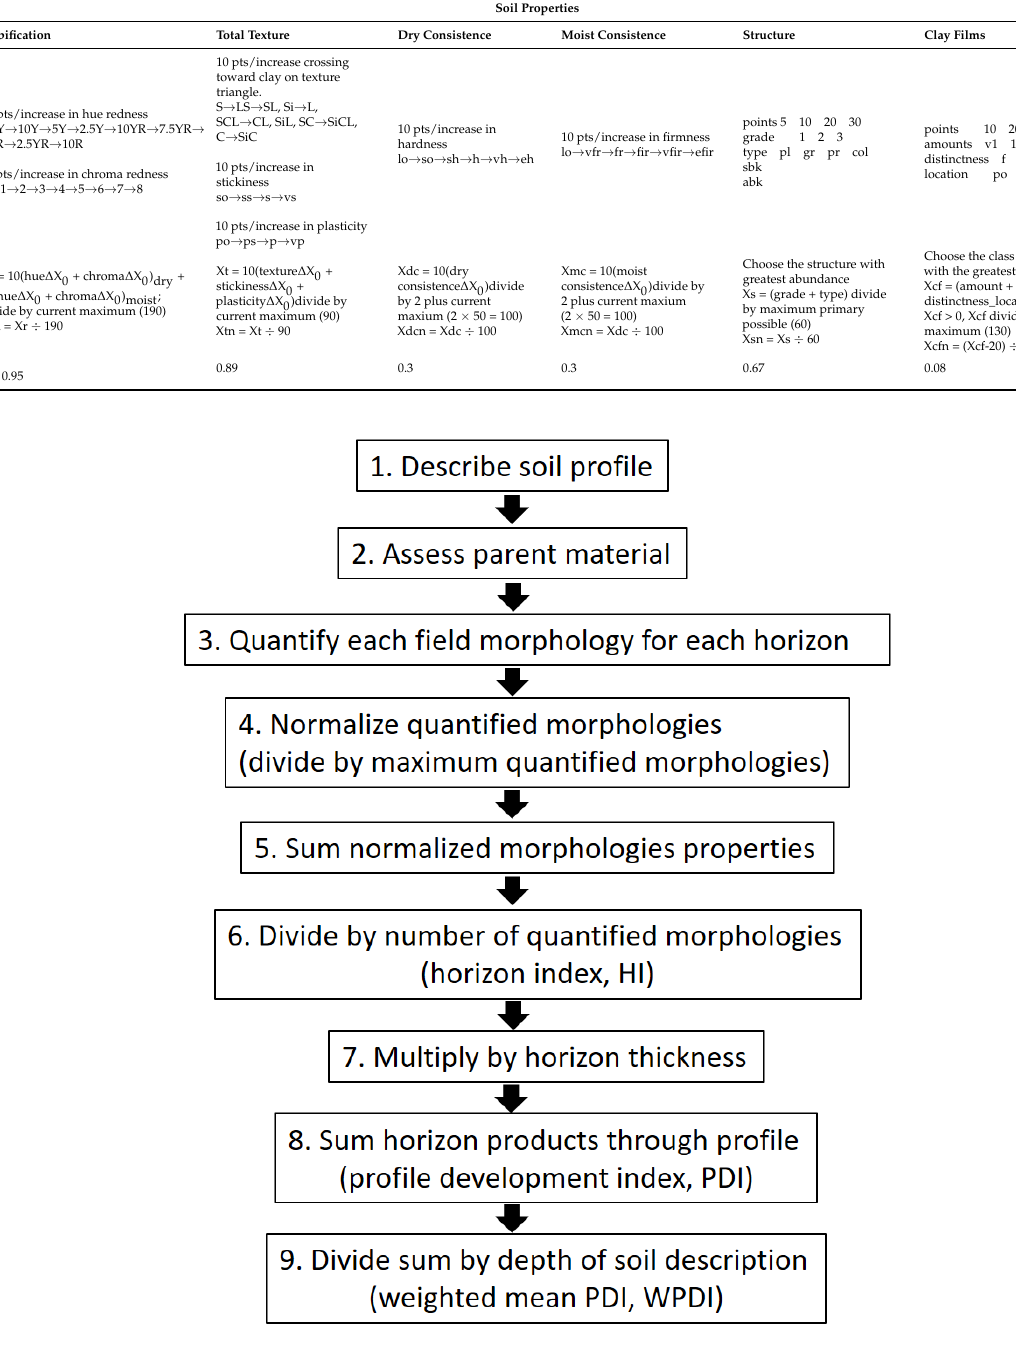
Figure 3. Flow chart for calculating the HI or WPDI. Redrawn and modified from Harden and Taylor [42].